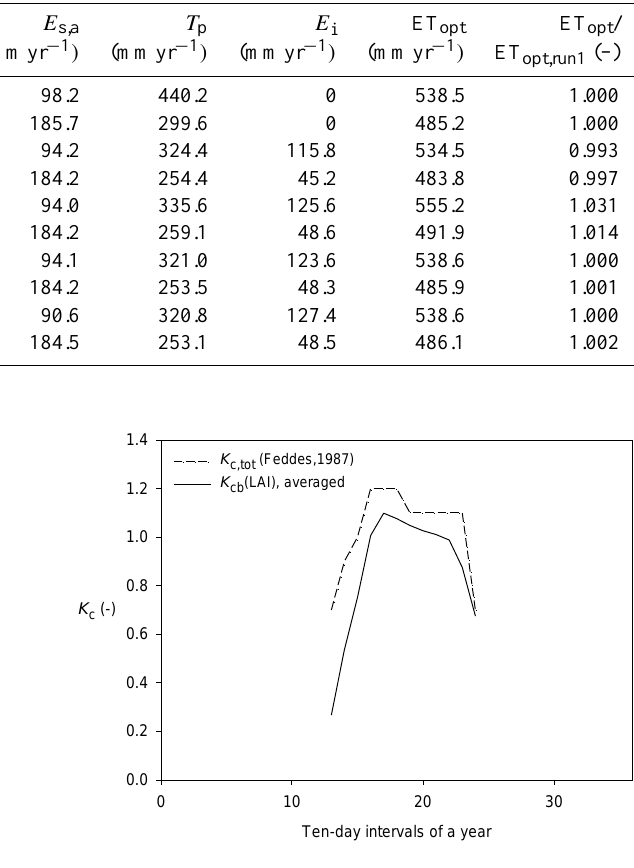
Fig. B4 Fig. B4. Comparison between K Fig. B5 Fig. B5. Comparison between K c,tot coefficients as given by Fed- c,tot coefficients as given by Fed- des (1987) for grassland and values of K cb (LAI) for the year with des (1987) and values of K cb (LAI) averaged for ten-day intervals median precipitation surplus (year 2000, in 1971–2000). of a calendar